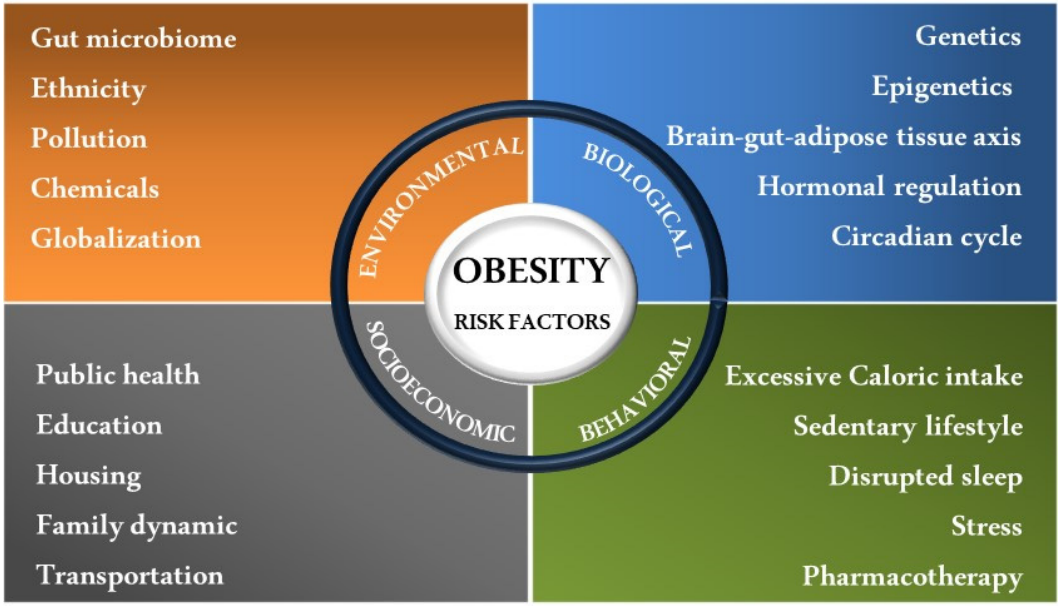
Figure 1. Obesity-attributable risk factors. Targetable individual behavioral, societal, biological, and environmental factors that contribute to the complex etiology of obesity and obesity-related metabolic complications in humans.